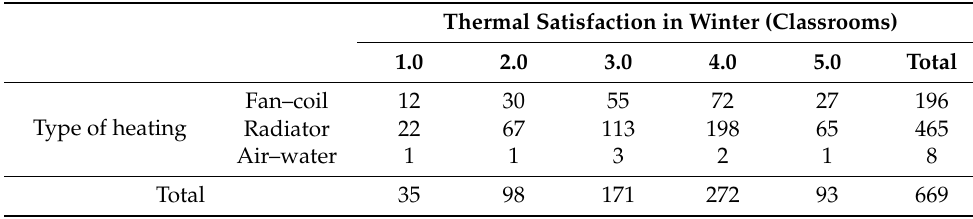
Table 7. Contingence table for thermal satisfaction in winter (classrooms) and type of heating.